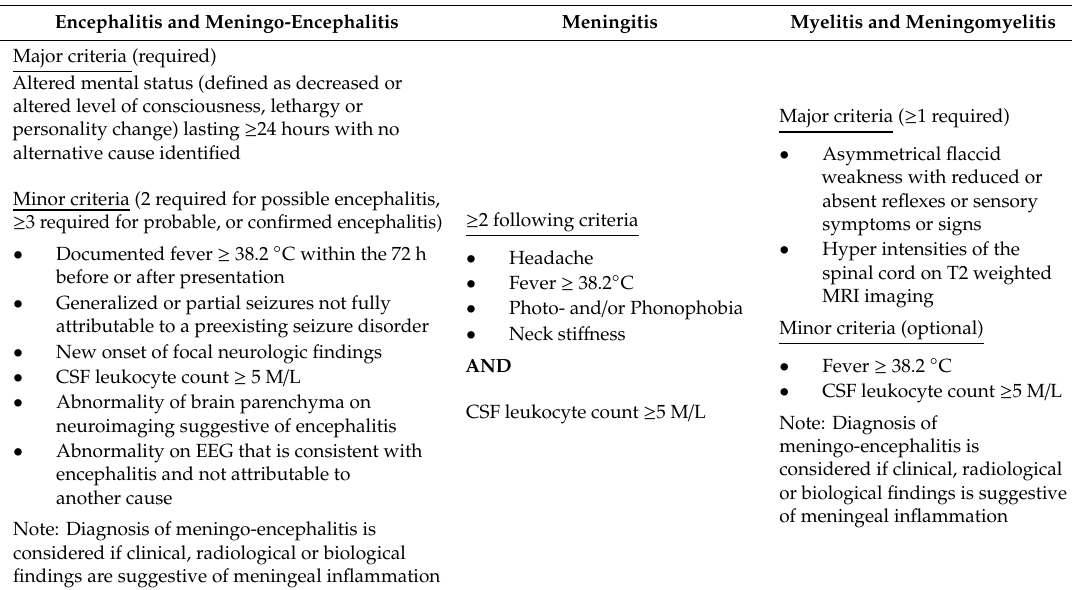
Table 1. Acute central nervous system (CNS) inflammation definitions. Encephalitis and Meningo-Encephalitis Meningitis Myelitis and